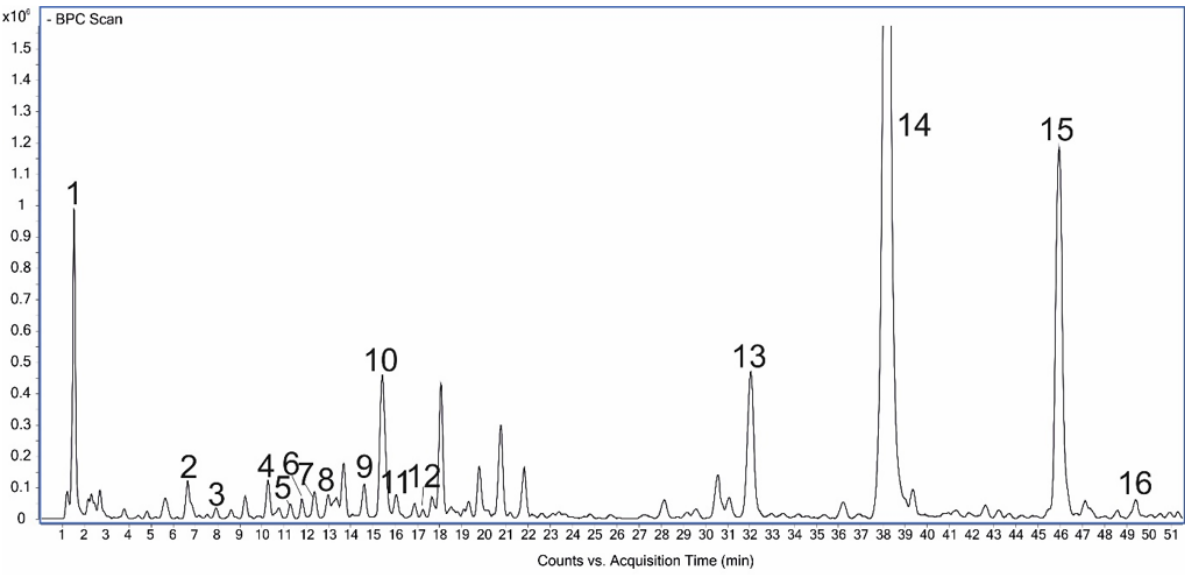
Figure 2. Chromatogram of P. amboinicus leaf extract with peaks identified via UHPLC-MS. (1)